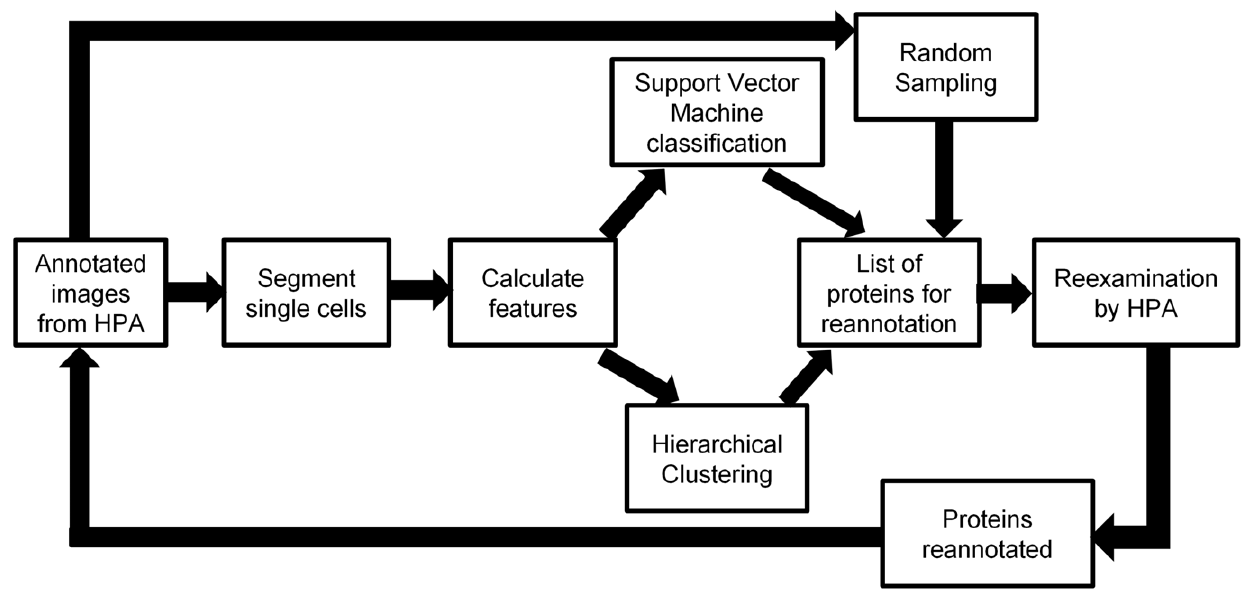
Figure 1. An overview of the framework introduced in this paper. We first collect immunofluorescence images from confocal microscopy that are annotated visually by HPA. These image fields are then segmented into single cells and various features (SLFs) are calculated. We then do two parallel analyses on the features. One is a supervised classification using a Support Vector Machine, and the other is an unsupervised hierarchical clustering. This results in two lists of proteins which have high probabilities of needing reannotation. Combined with another list of proteins sampled randomly, a final list which contains only the protein IDs are reexamined by the HPA annotation group. The annotations of some proteins may change, and these modified annotations can be incorporated in another cycle of analysis. images for 1551 proteins, of which 878 were localized specifically (solely) to one of eleven major subcellular location patterns (classes): centrosome, cytoplasm, cytoskeleton, endoplasmic retic- ulum, Golgi, lysosome/peroxisome/endosome, mitochondria, nucleoli, nucleus, nucleus without nucleoli, and plasma mem- brane. The number of proteins per class ranged from five to 326.